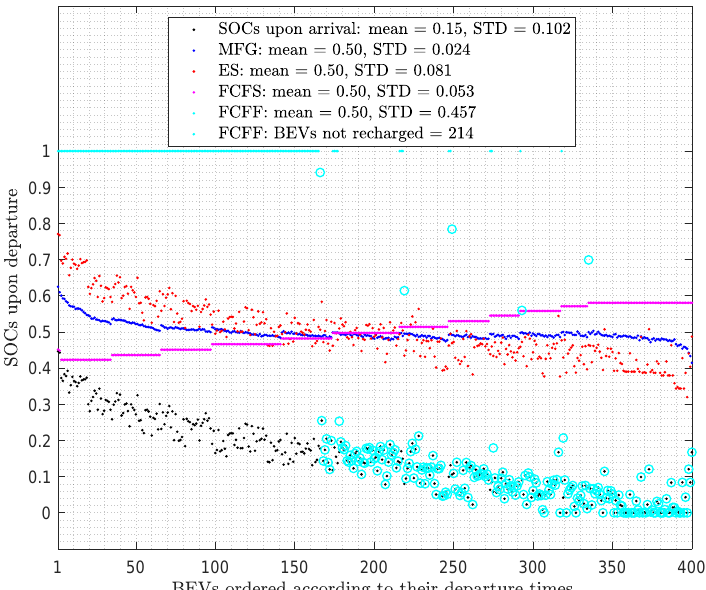
Figure 14. SOC levels at time of departure for of a fluctuating population of 400 BEVs in the cloudy